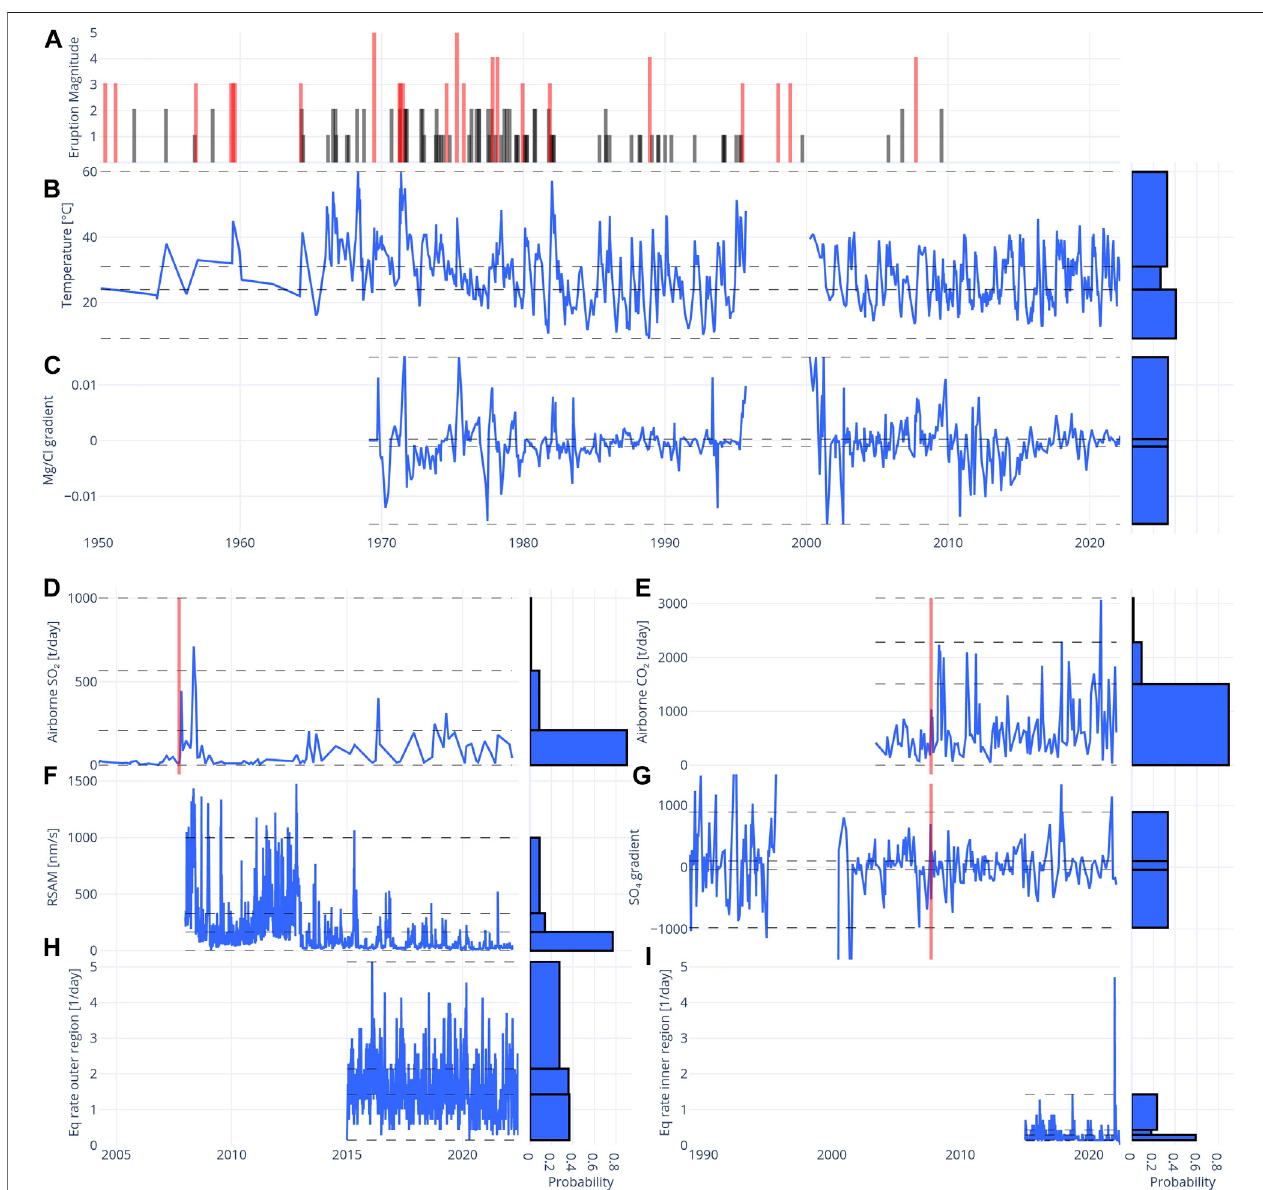
FIGURE 5 | Time series of key parameters in the model and the discretisation intervals of the variables. The panels to the right of each time series show the histograms for the respective discretisation intervals. (A) Eruption history with events size 3 or larger shown in red. (B) Lake temperature. (C) Mg:Cl ratio, (D,E) Airborne SO2 and CO2 fl ux respectively, (F) RSAM, (G) SO4 concentration, (H) Earthquake rate in the outer region, (I) Earthquake rate in the inner region.